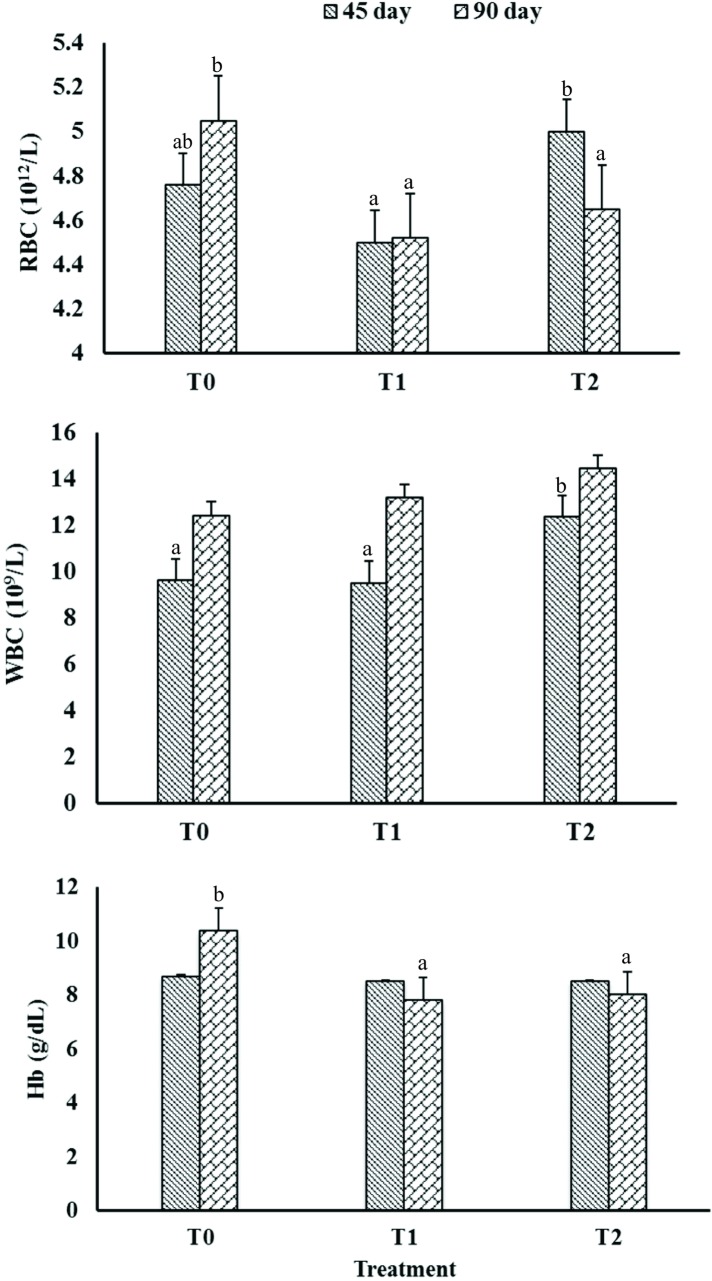
Effect of probiotics on red blood cells (RBC; 1012/L), white blood cells (WBC; 109/L) and haemoglobin (Hb; g/dL) percentage in crossbred weaning pigs.